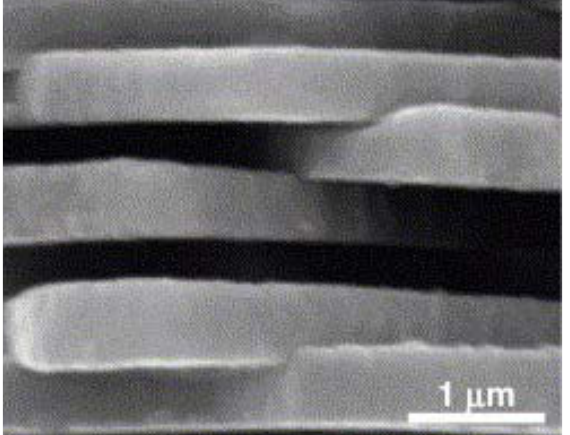
Figure 3. SEM image of a fractured nacre surface showing presence of interlocking between platelets of nacre responsible for its mechanical response. Reproduced from [14] with permission from